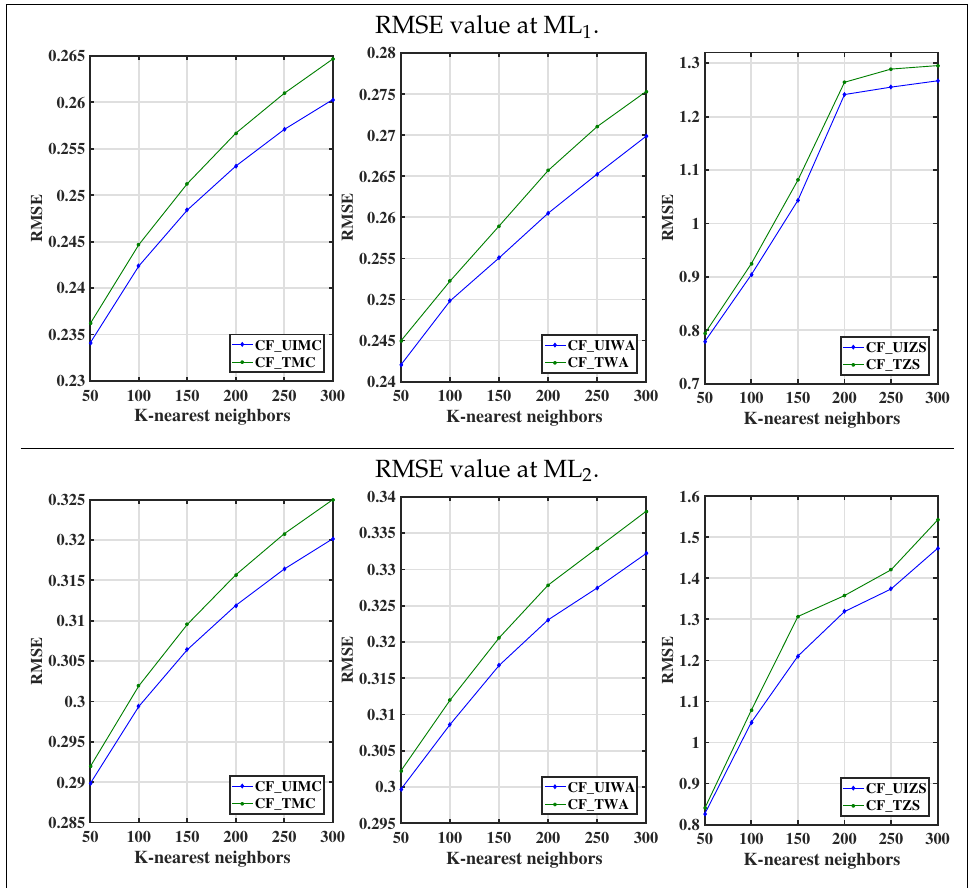
Figure 4. RMSE Value at